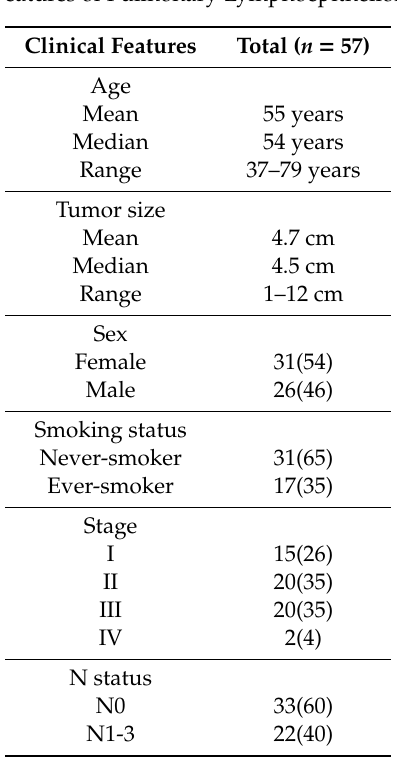
Table 1. Clinicopathologic Features of Pulmonary Lymphoepithelioma-Like Carcinoma